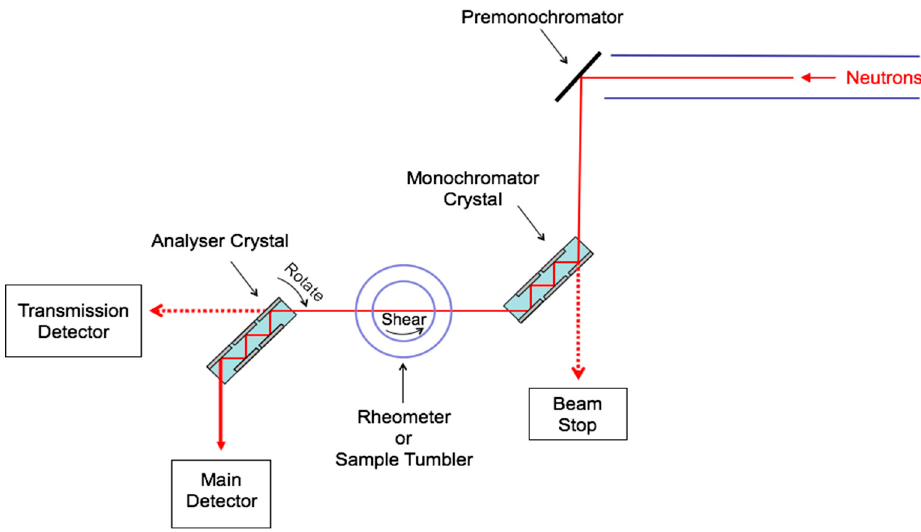
Figure 1. Sketch of the Kookaburra USANS instrument layout.